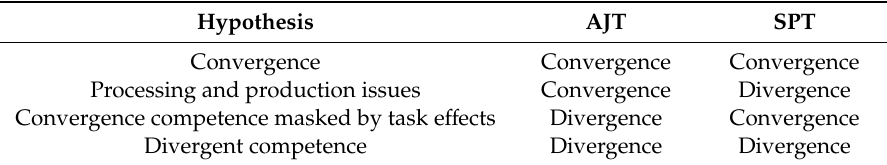
Table 2. Hypotheses and relevant predictions for each